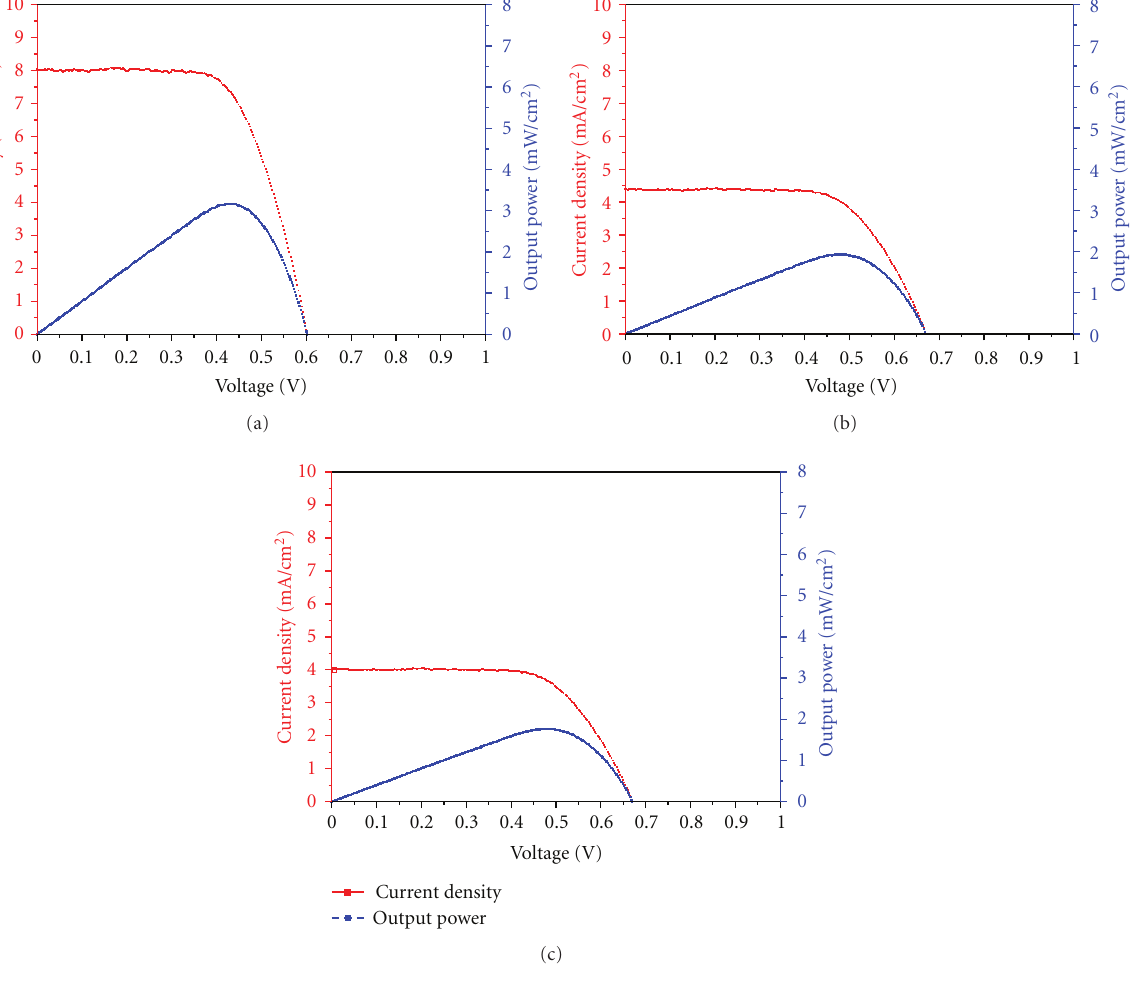
Figure 6: (a) Simulation results at 75 ◦ C, 1000 W/m 2 , 0% shadowing rate. (b) Simulation results at 25 ◦ C, 600 W/m 2 , 0% shadowing rate. (c) Simulation results at 25 ◦ C, 1000 W/m 2 , 50% shadowing